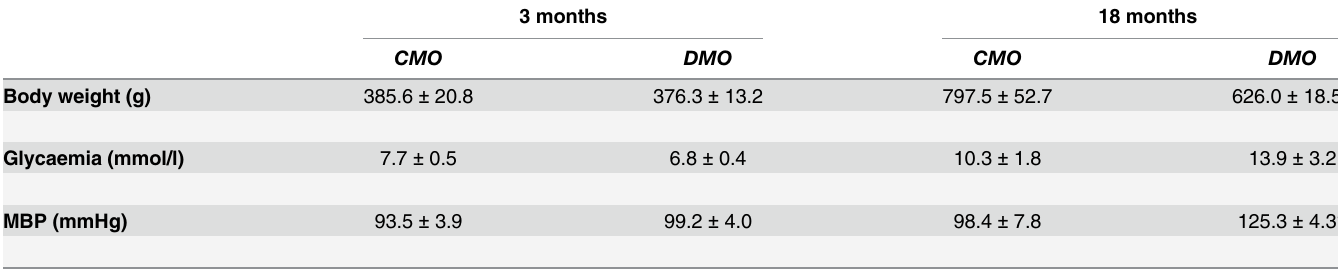
Table 1. Physiological parameters of control mother offspring (CMO) and diabetic mother offspring